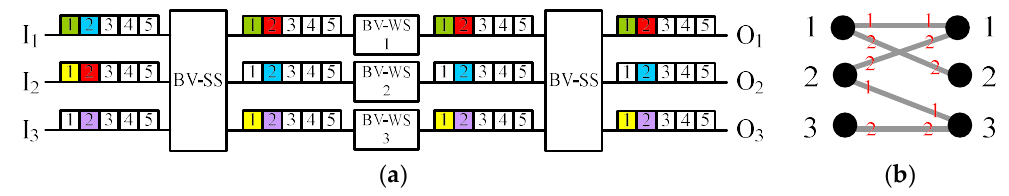
Figure 2. A frame F consisting of connections (1, 1, 1), (1, 2, 1), (2, 3, 1), (2, 1, 1), and (3, 3, 1) is given in an SWS1(3, 3, 5) switching fabric. ( a ) A routing of connections in F under Routing Algorithm 1 referring to the edge-coloring given in ( b ). ( b ) The corresponding graph G F of ( a ), in which colors 1 and 2 (marked in red font) are adopted for edge-coloring.